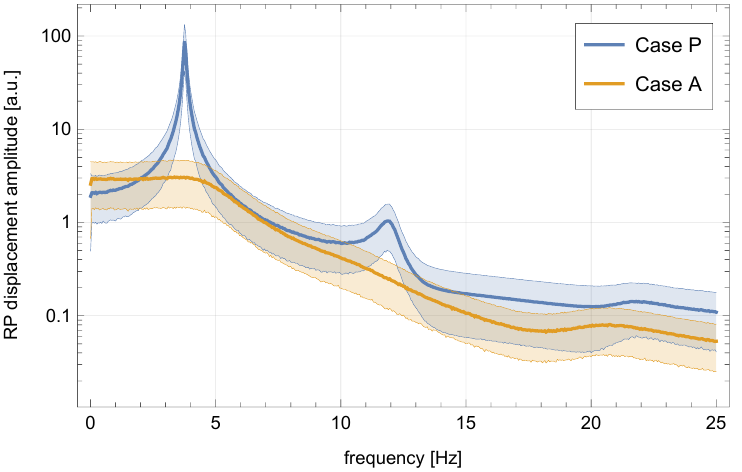
Figure 7. Frequency-domain amplitudes of the RP displacement responses together with their ± σ bands for the passive and fully controlled structures (in arbitrary units, a.u.).